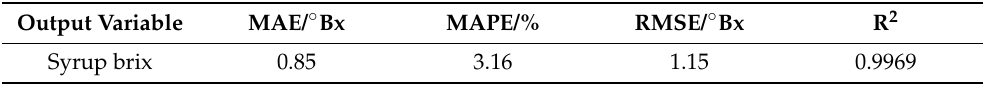
Table 8. Evaluation index of syrup brix online